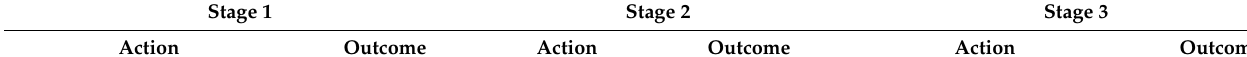
Table 2. The evolution of behavioural